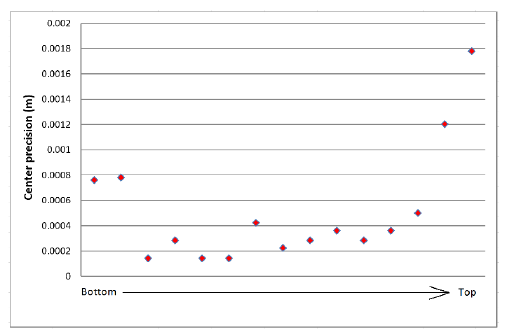
Figure 9. The precision of center coordinates for different sections, from bottom to top of the chimney.